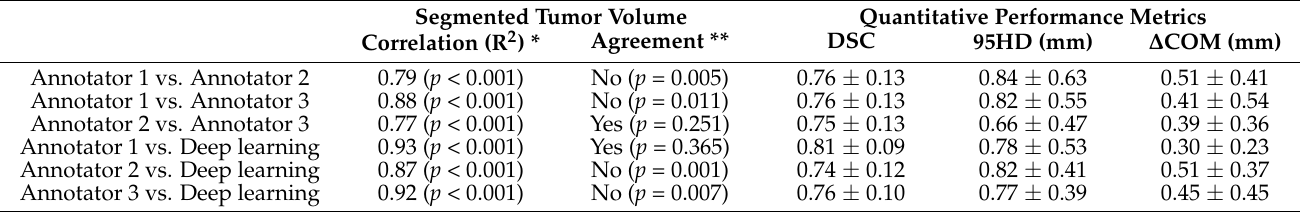
Table 1. Subjectivity and bias in human